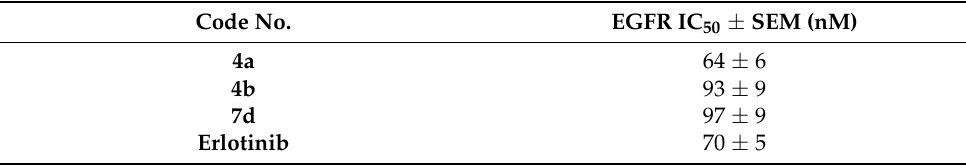
Table 3. IC 50 of compounds 4a , 4b, and 7d against EGFR. Code No.